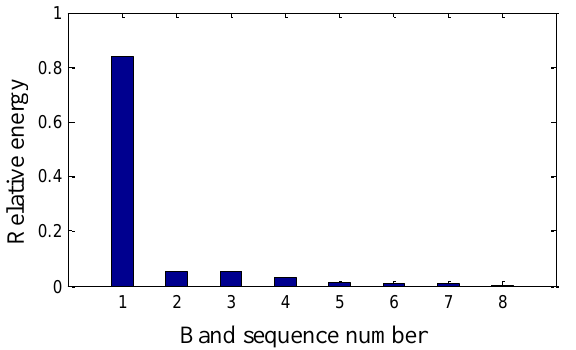
Figure 18. The sensor-dependent signal’s relative energy distribution in level 3 after maintenance. It is inferred that the relative energy from the second frequency band to the fourth frequency band in Figure 10 is caused by the machinery’s fault information concerning the gaps in the #4 bearing